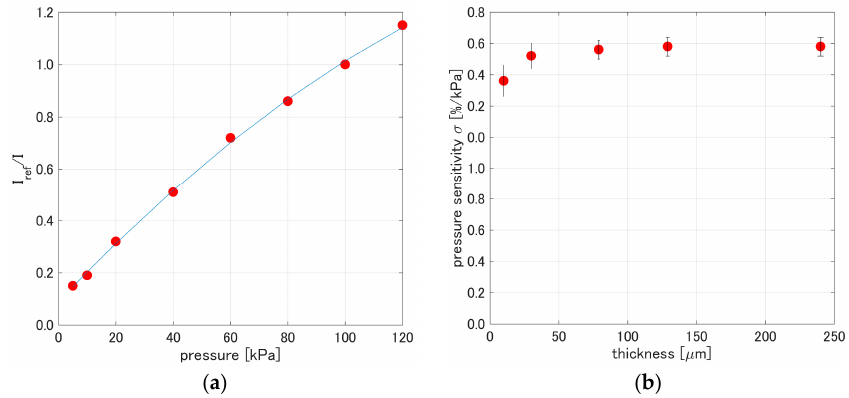
Figure 6. ( a ) Pressure calibration of PCPSP th 01 ; ( b ) Pressure sensitivity related to PC-PSP thickness.